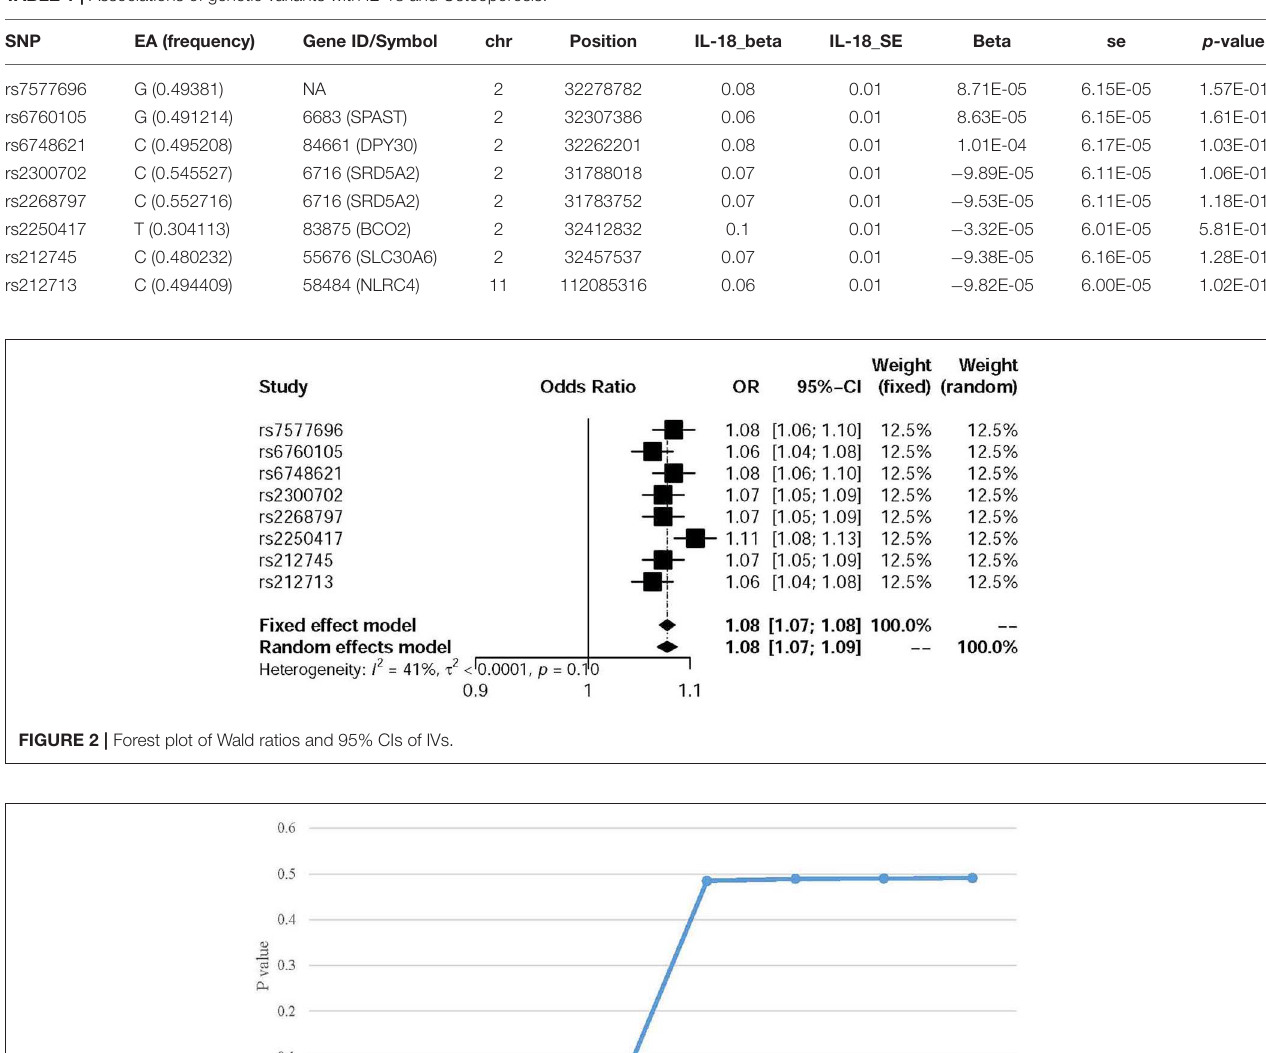
TABLE 1 | Associations of genetic variants with IL-18 and Osteoporosis.